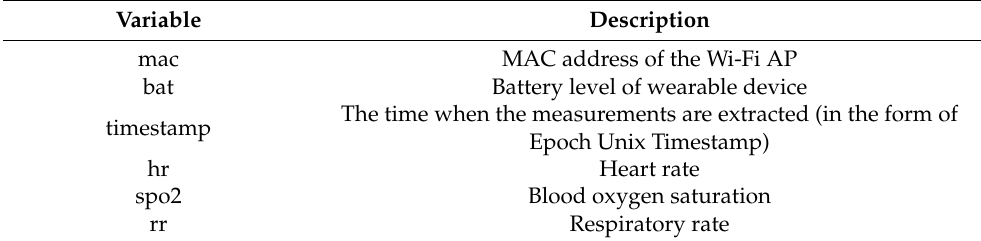
Figure 7. API service parametric URL.